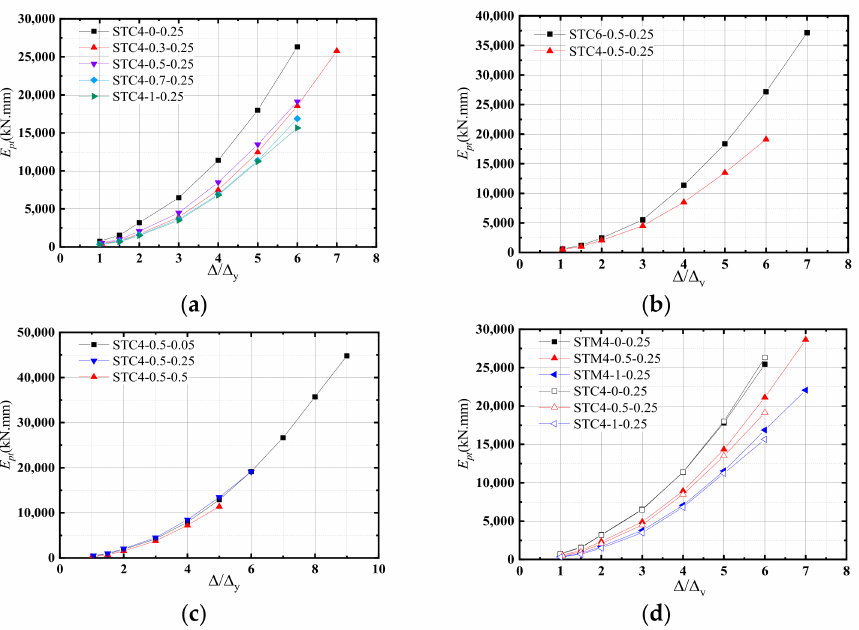
Figure 13. ( a ) Strength degradation coefficient curve λ j - ∆ / ∆ y for different replacement ratios of RBA; ( b ) strength degradation coefficient curve λ j - ∆ / ∆ y for different steel tube thicknesses; ( c ) strength degradation coefficient curve λ j - ∆ / ∆ y for different axial compression ratios; ( d ) strength degradation coefficient curve λ j - ∆ / ∆ y for different cementitious